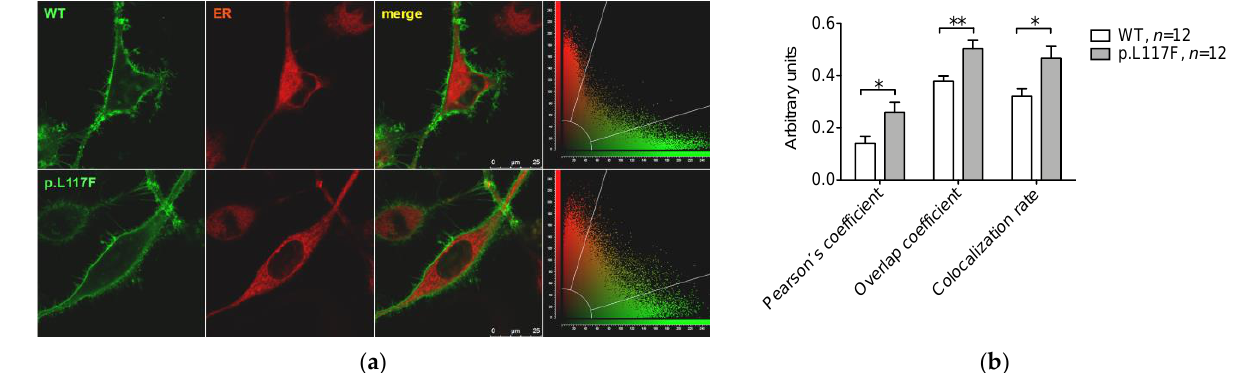
Figure 4. Colocalization of human wild-type pendrin and pendrin variant p.L117F with the endo- plasmic reticulum. ( a ) Representative images of living Hela cells transfected with wild type (WT) or p.L117F SLC26A4 -EYFP (green) and stained with the endoplasmic reticulum (ER) marker ER-Track- er TM Red (red). The corresponding merge images and scatter plots are shown. Scale ba r: 25 μm. ( b ) Average Pearson´s correlation coefficient, overlap coefficient, and colocalization rate. n refers to the number of cells from 3 independent subcultures. * p < 0.05, ** p < 0.01, unpaired, two-tailed Student´s t test.